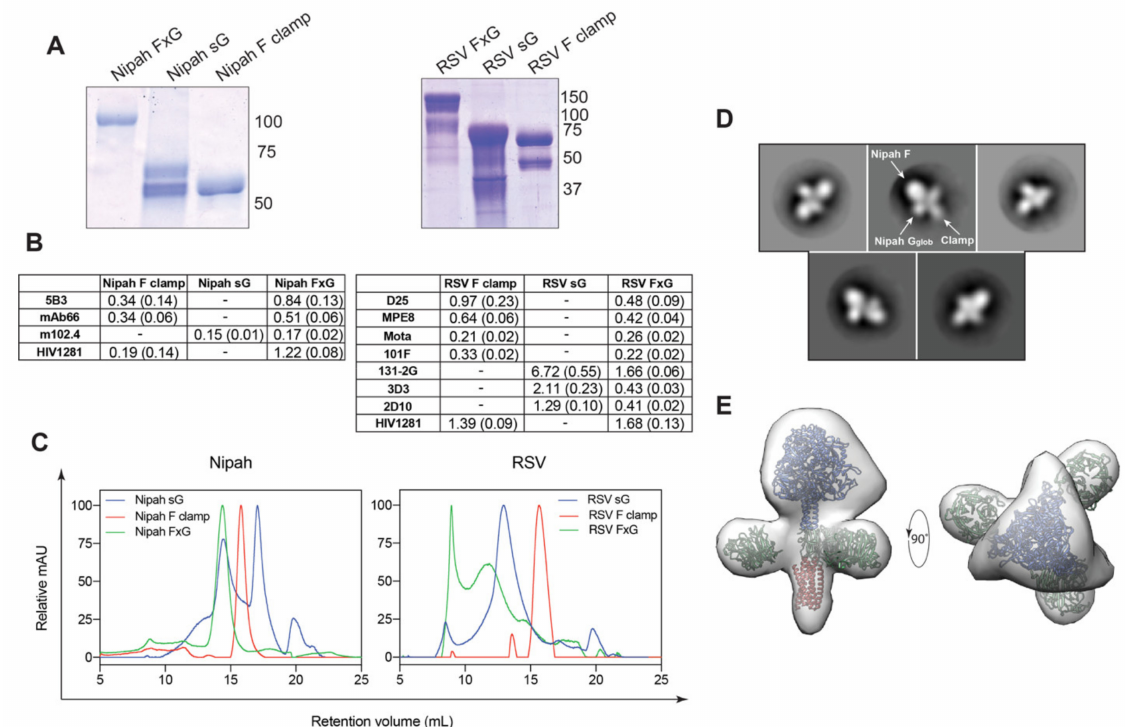
Figure 2. NiV and RSV FxG antigen characterisation. ( A ) SDS-PAGE of NiV (left) and RSV (right) purified antigens run under reducing conditions. Uncropped gels are provided in Figure S1. ( B ) K d in nM of NiV mAbs (left) and RSV mAbs (right) against F clamp, sG and FxG antigens with standard error shown in parentheses and dashed line showing no applicability. K d are calculated from indirect ELISAs of mAbs against purified proteins, shown in Figure S1. An additional clamp-specific mAb (HIV1281) is included as a control. ( C ) SEC of NiV (left) and RSV (right) antigens ran on Superose 6 Increase 10/300GL column and normalised to the highest mAU value of each run. ( D ) Representative two-dimensional class averages of NiV FxG obtained from negative stain electron microscopy with annotations depicting potential domains of FxG. ( E ) An initial ~30 Å three-dimensional model of NiV FxG antigen obtained from negative stain electron microscopy analyses with known structures of NiV F (PDB 5EVM), NiV G head domain (PDB 3D11) and clamp domain (PDB 1AIK) fitted and coloured in blue, green and red